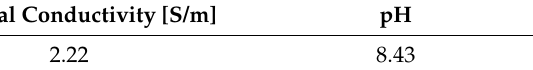
Table 5. Seawater characteristics.